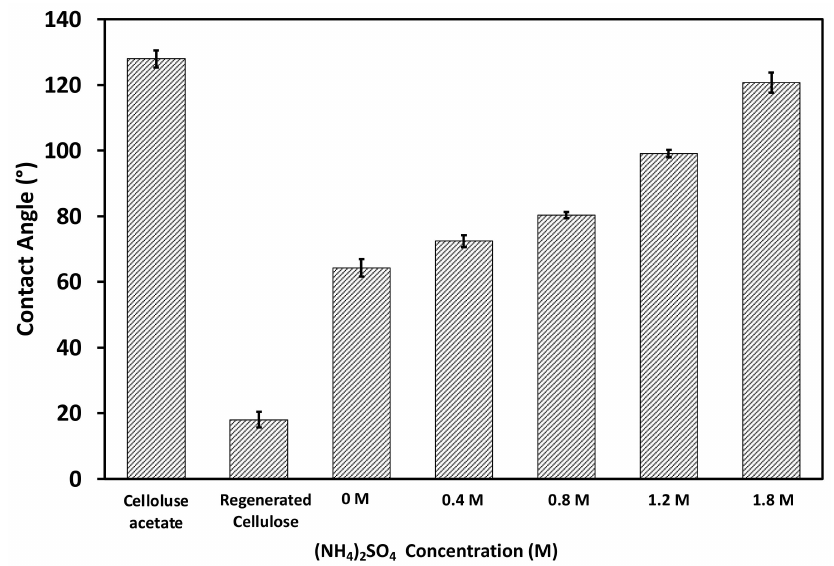
Figure 5. Contact angles of the electrospun CA, the subsequently hydrolyzed RC membrane sub- strates, as well as PVCL immobilized RC membranes under different concentrations of (NH 4 ) 2 SO 4 salt